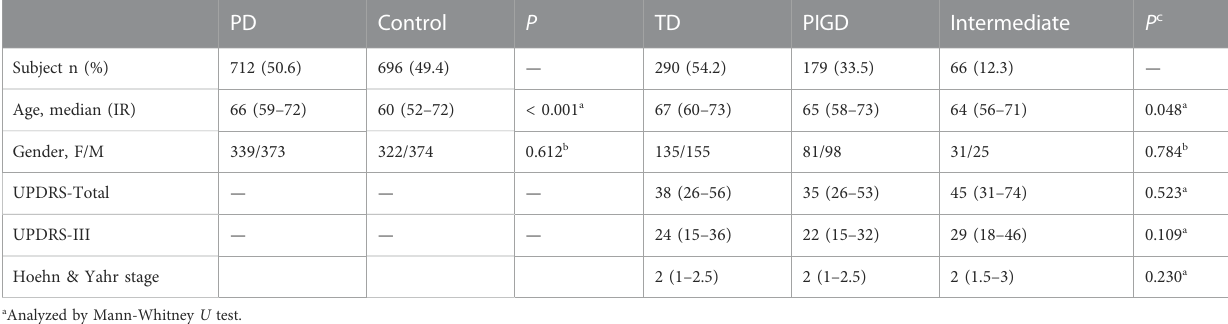
TABLE 1 Demographic and clinical